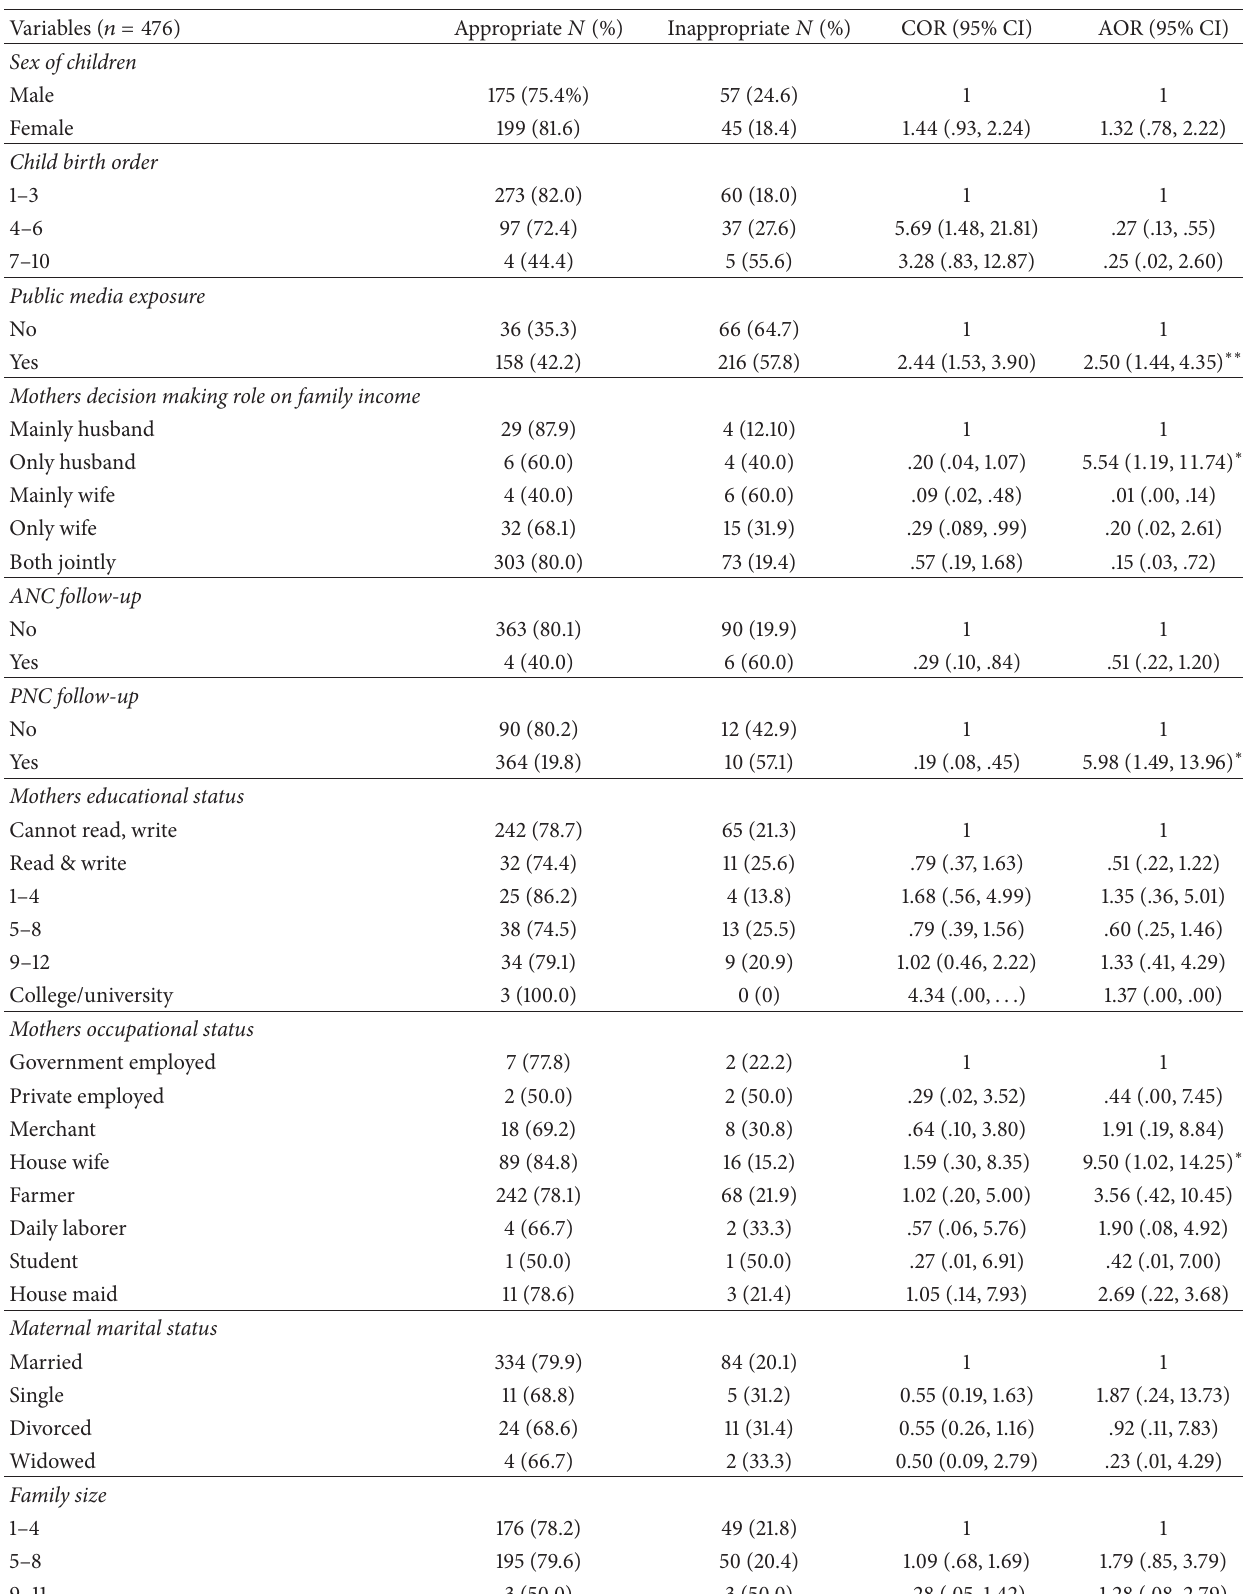
Table 3: Factors associated with inappropriate complementary feeding practice among mothers who had 6–23-month-old children at Lasta Woreda, Amharra, Northern Ethiopia, April to October